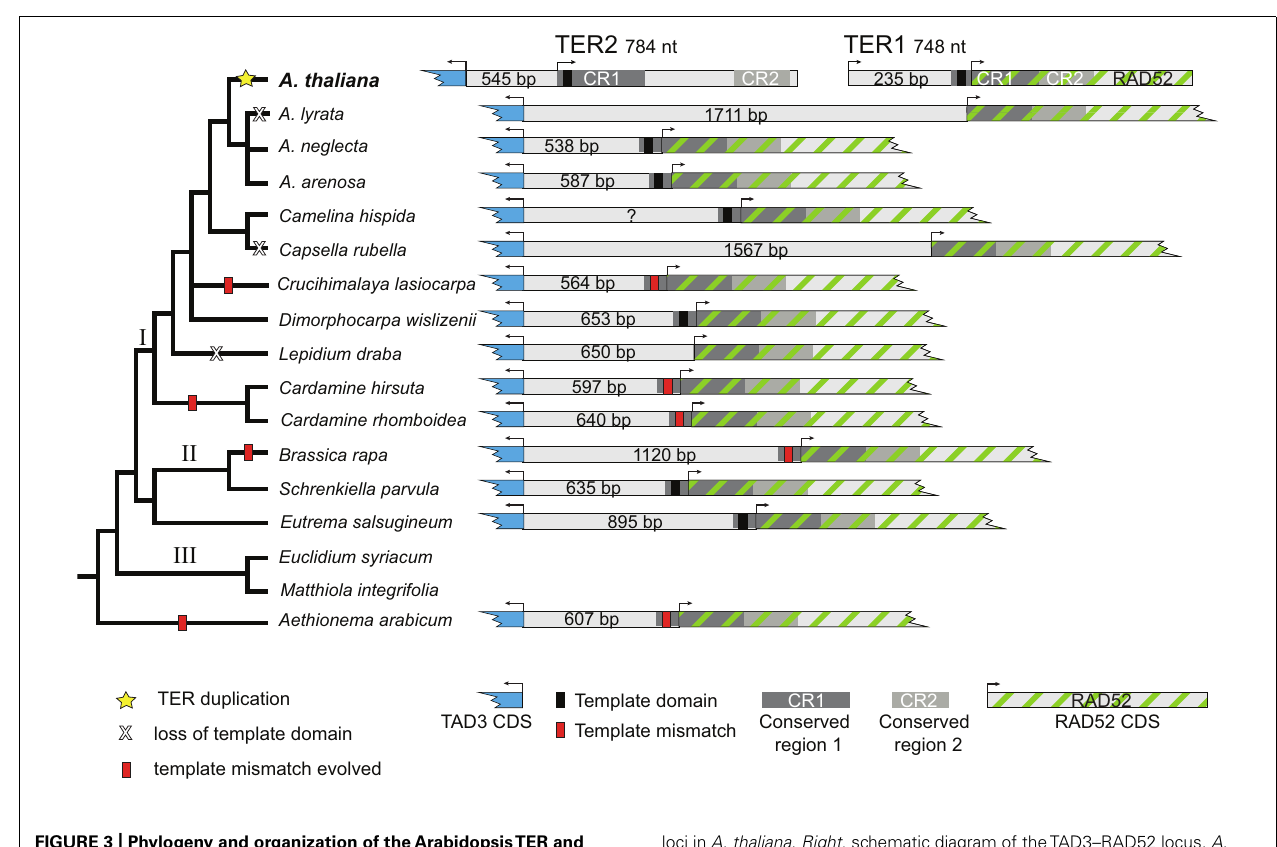
FIGURE 3 | Phylogeny and organization of theArabidopsisTER and putativeTER loci in Brassicaceae. Left , Brassicaceae tree modified from Beilstein etal. (2010).The most parsimonious reconstruction of theTER locus in Brassicaceae is depicted. Shown are species sampled in this study. Species in lineage III from whichTER loci were not obtained are also included for context.Yellow star indicates the duplication event that produced twoTER